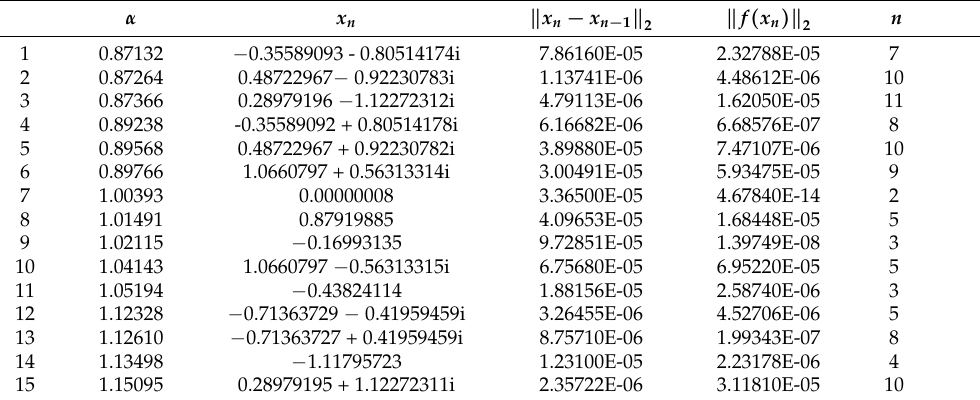
Table 4. Results obtained using the iterative method (51).